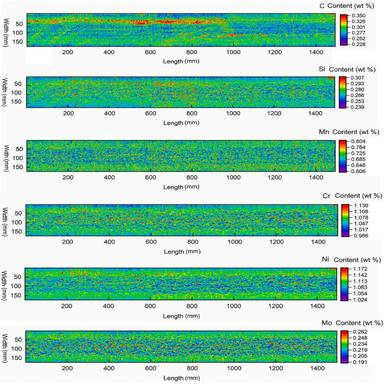
Corrected 2-D content distribution of C, Si, Mn, Cr, Ni, Mo in A1H sample.